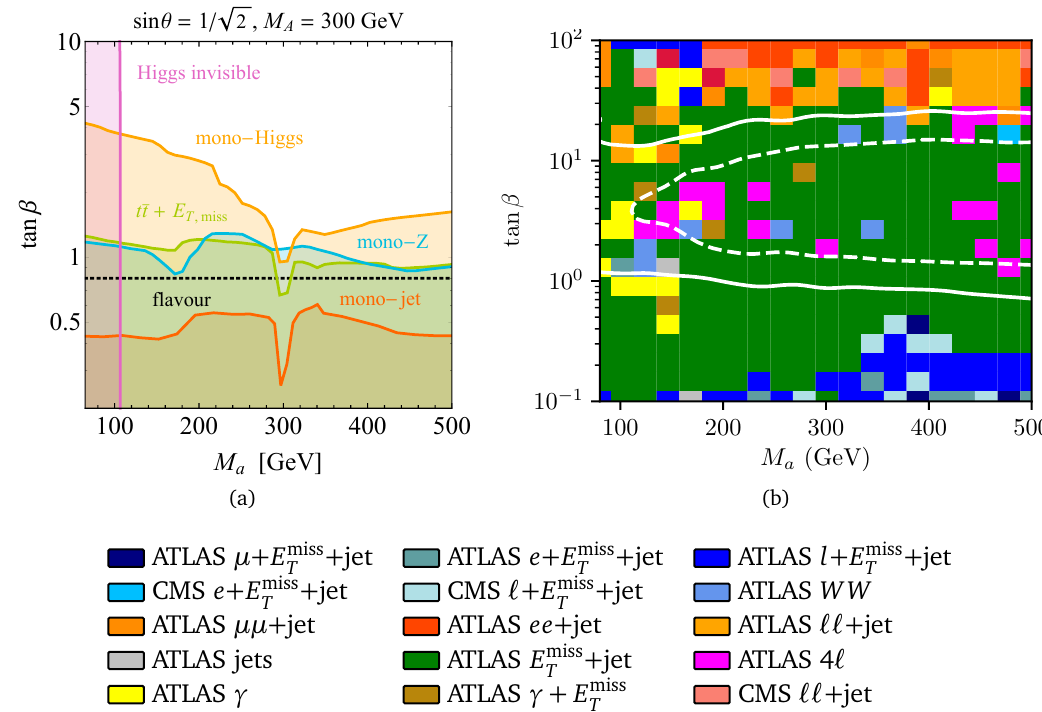
Figure 2: (a) Sensitivity scan from [ 1 ] (see text), (b) C ONTUR scan over the same parameters, but extended to higher tan β . The 95% (68%) excluded contours are indicated by solid (dashed) white lines; the colours indicate the most sensitive set of